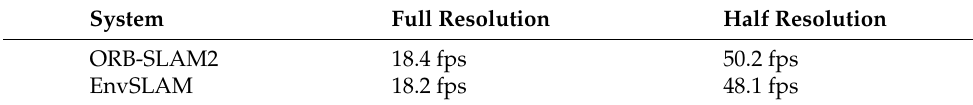
Table 5. Average frames per second at which ORB-SLAM2 and EnvSLAM can